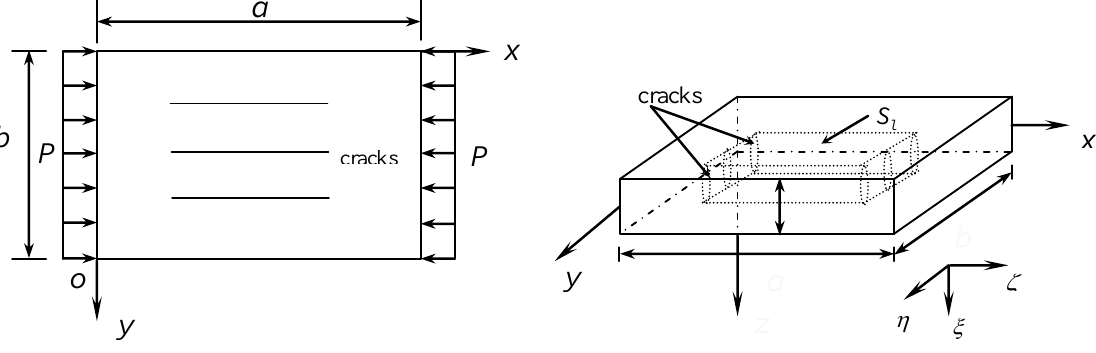
Figure 2. Geometric configuration of a piezoelectric plate with transverse cracks under the uniform compressive in-plane